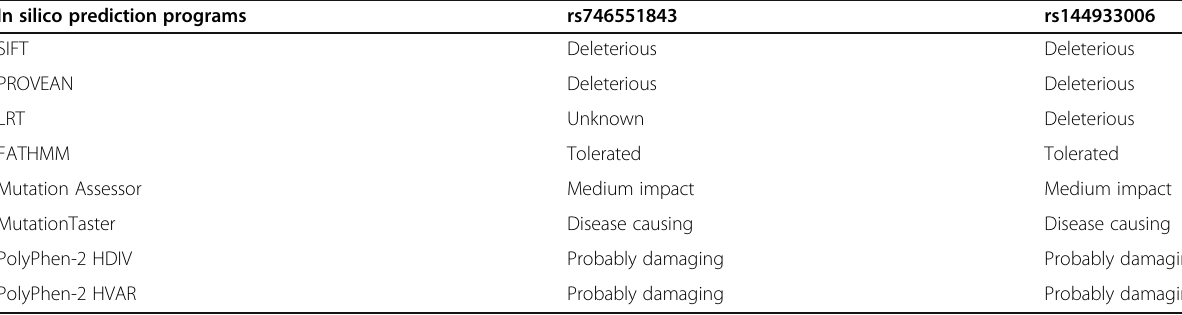
Table 1 Effect of genetic variants according to in silico prediction programs In silico prediction programs